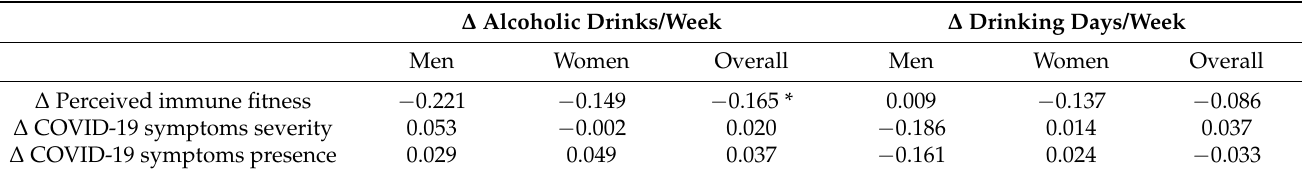
Table 7. Relationship between changes in perceive immune fitness and COVID-19 symptoms with alcohol consumption outcomes.